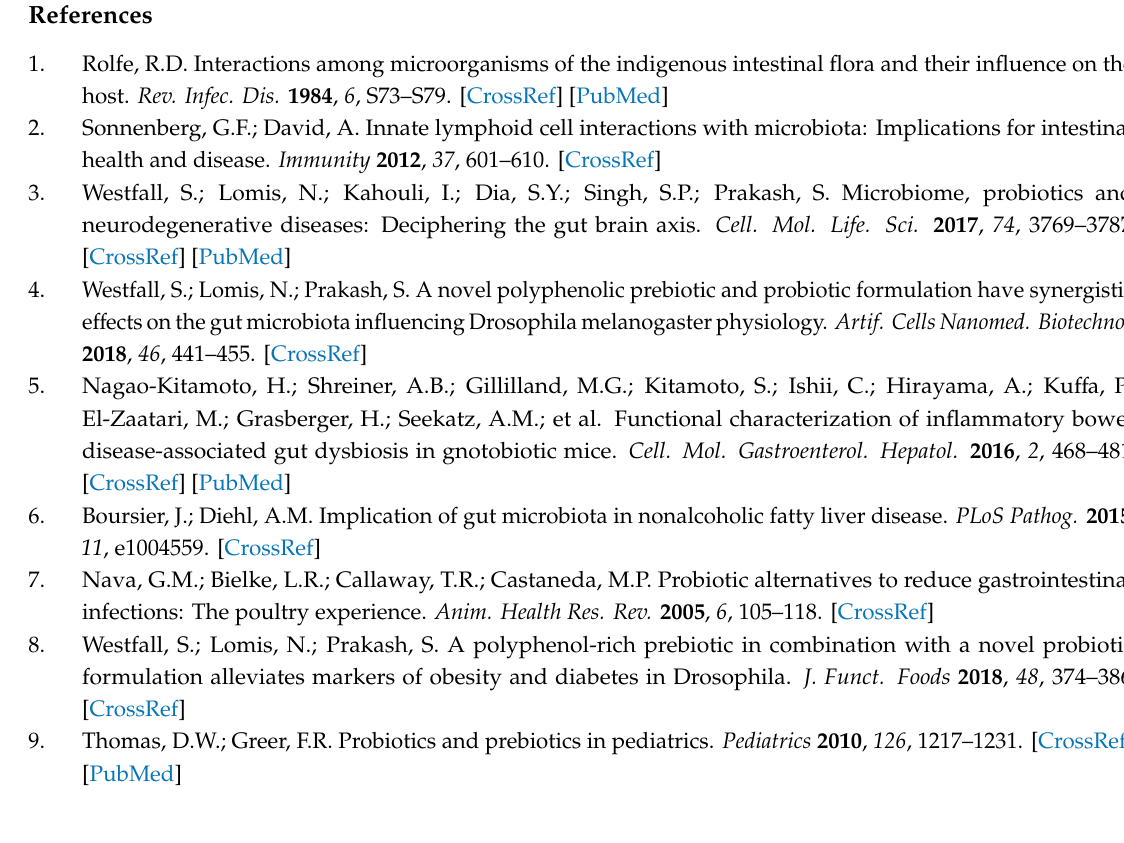
Table S1. Primer sequences used for qRT-PCR in this